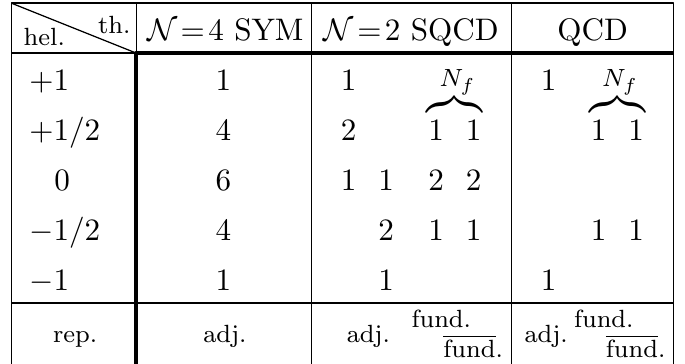
Table 1. Helicity content of = 2 supersymmetric QCD in comparison to N Mills theory and conventional QCD. For these theories, the helicities and the representations of the particles are listed in the left column and the lower row,